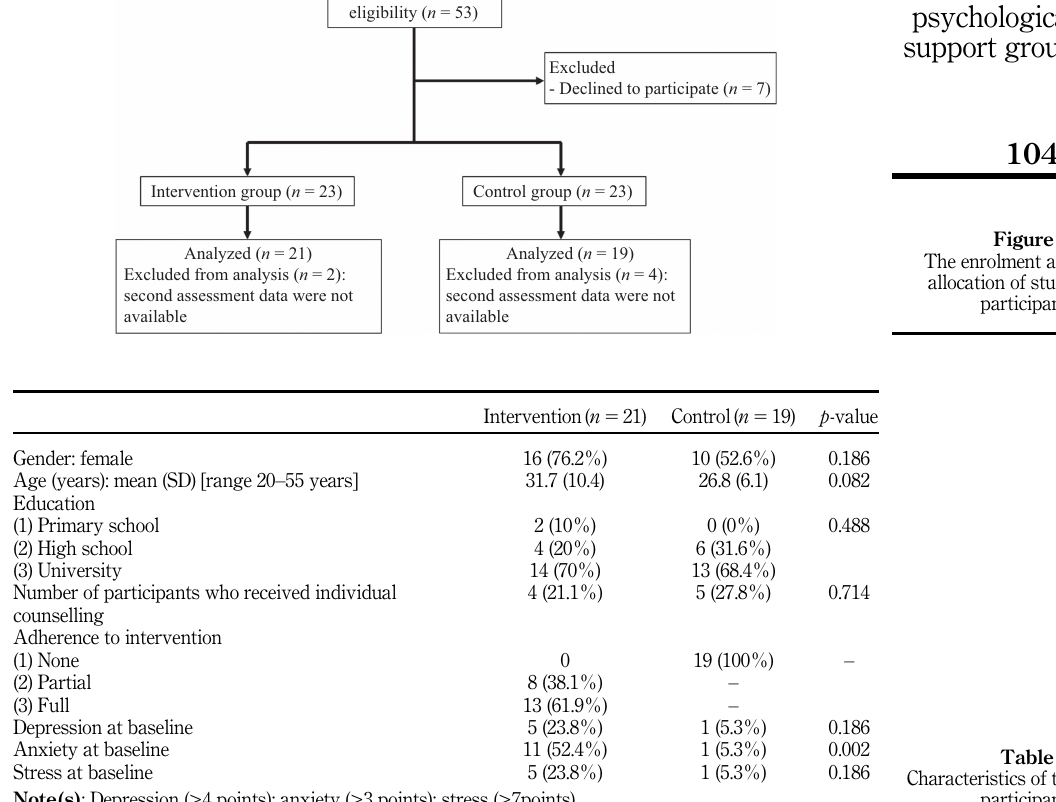
Table 1. Characteristics of